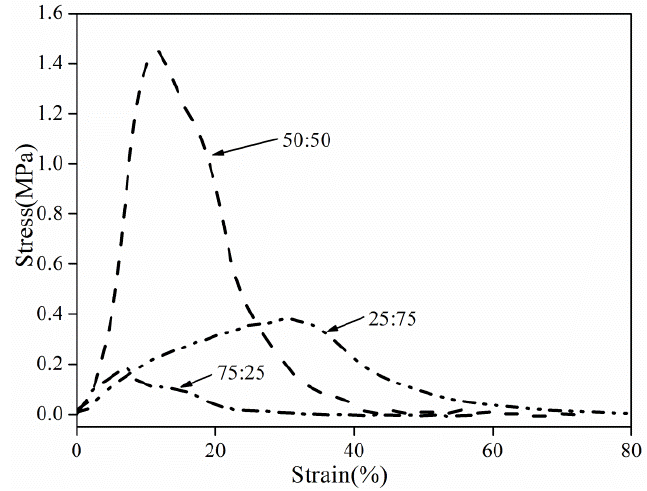
Figure 11. Stress-strain curves of electrospun PS nanofibrous